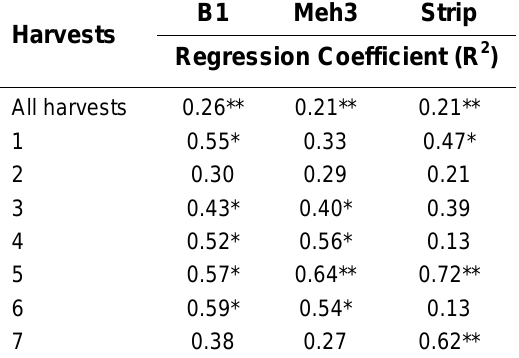
Regression Coefficients for B1, Meh3, and Strip Extractable P on Setaria P Uptake B1 Meh3 Strip Harvests Regression Coefficient (R 2 ) All